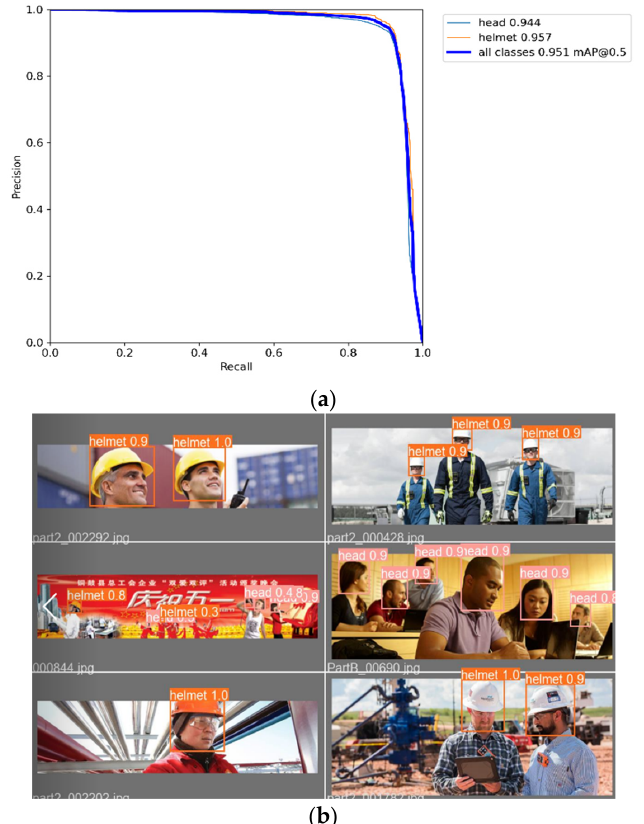
Figure 4. Training results of Safety Helmet Dataset on YOLOv5s. ( a ) Precision and Recall; ( b ) Training results of some samples.